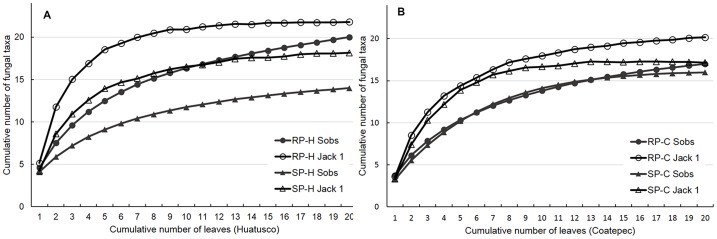
Rarefaction curves for fungal endophytes isolated from coffee leaves from the four coffee plantations.Species accumulation curves (gray circles and gray triangles) and Jackknife 1 estimated richness (open circles and open triangles) of rustic plantations (circles) and simple polycultures (triangles) of Huatusco region (A) and Coatepec (B). RP-H: rustic plantation Huatusco; RP-C: rustic plantation Coatepec; SP-H: simple polyculture Huatusco; SP-C: simple polyculture Coatepec.